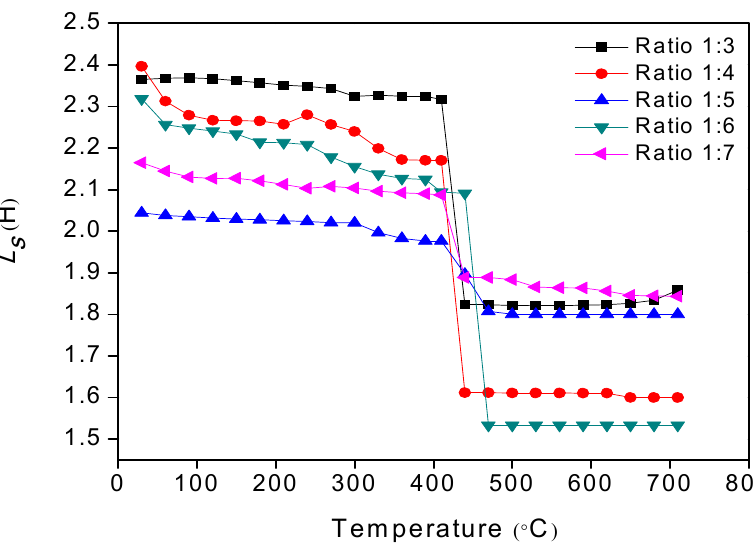
Figure 9. Curie temperatures of samples at different powder-to-salt weight ratios.